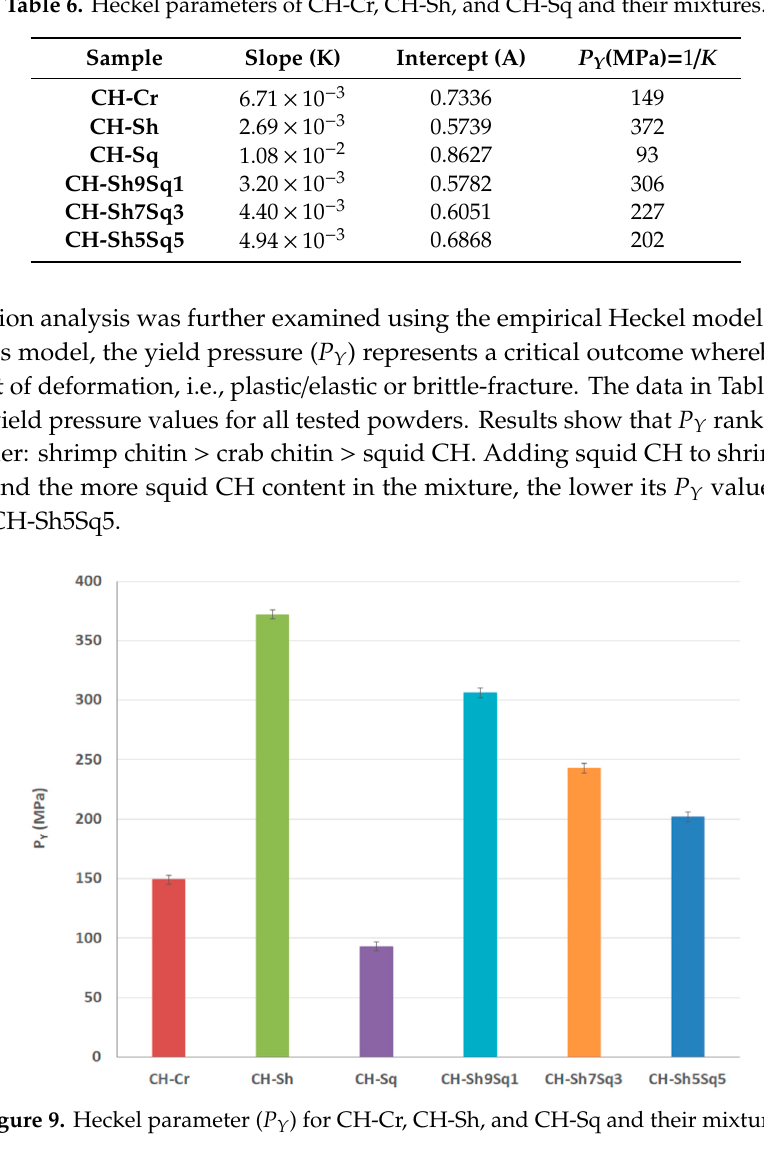
Figure 8. Kawakita plots of CH-Sh9Sq1, CH-Sh7Sq3, and CH-Sh5Sq5 CH mixtures. Table 6. Heckel parameters of CH-Cr, CH-Sh, and CH-Sq and their mixtures.